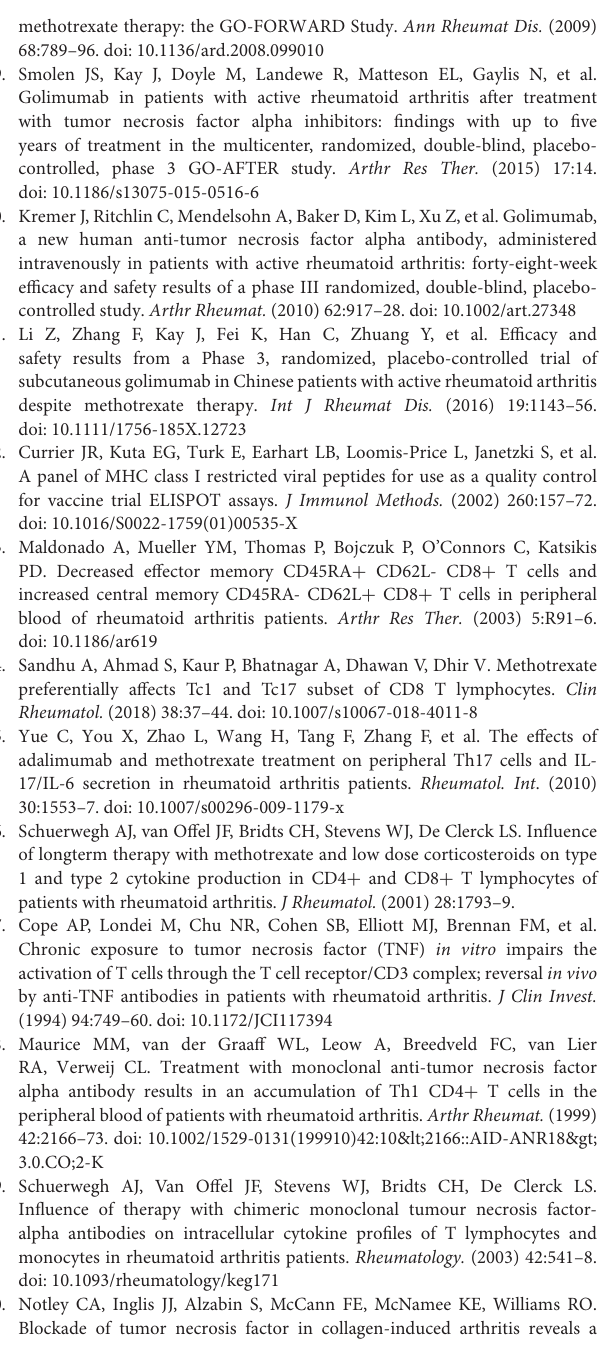
Supplementary Figure 4 | (A) List of HLA Class I restricted 23 peptides from CMV, EBV, and Flu virus. The viral antigen, the amino acid sequence and HLA class I alleles of each epitope were listed. (B) Peptides were pooled into 12 groups (Pool A to pool J, FLU pool and EBV pool) for peptide stimulation assay. Those who reacted to both pool A and pool J were responded to Pep-05 (FLU peptide GILGFTFVL) with HLA-A2 restriction. (C) Representative of IFN- γ ICS analysis responding to pool A, pool J and FLU in one healthy control individual, one GM untreated patient and one GM treated